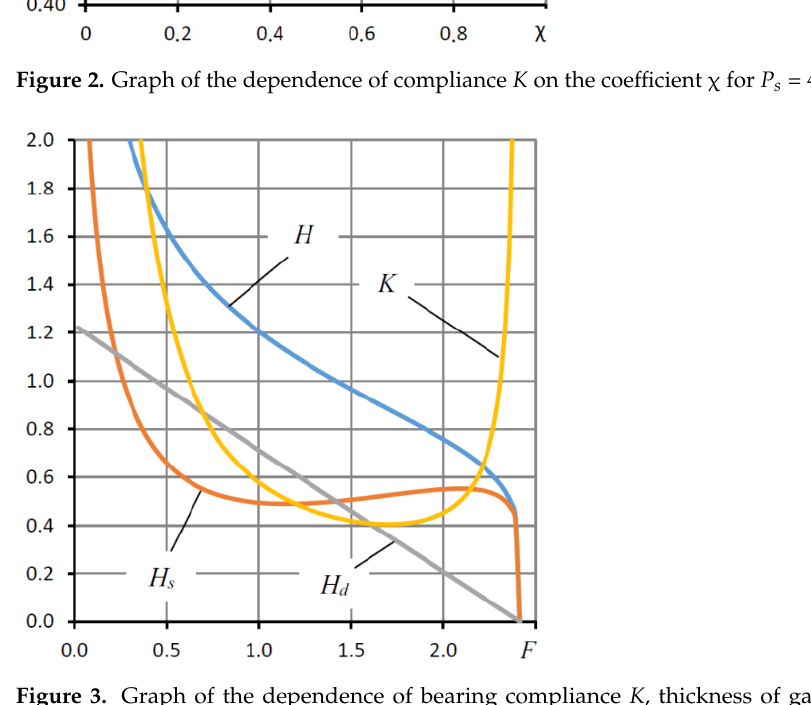
Figure 3. Graph of the dependence of bearing compliance K , thickness of gaps H and H s , and deformation H d on load F .